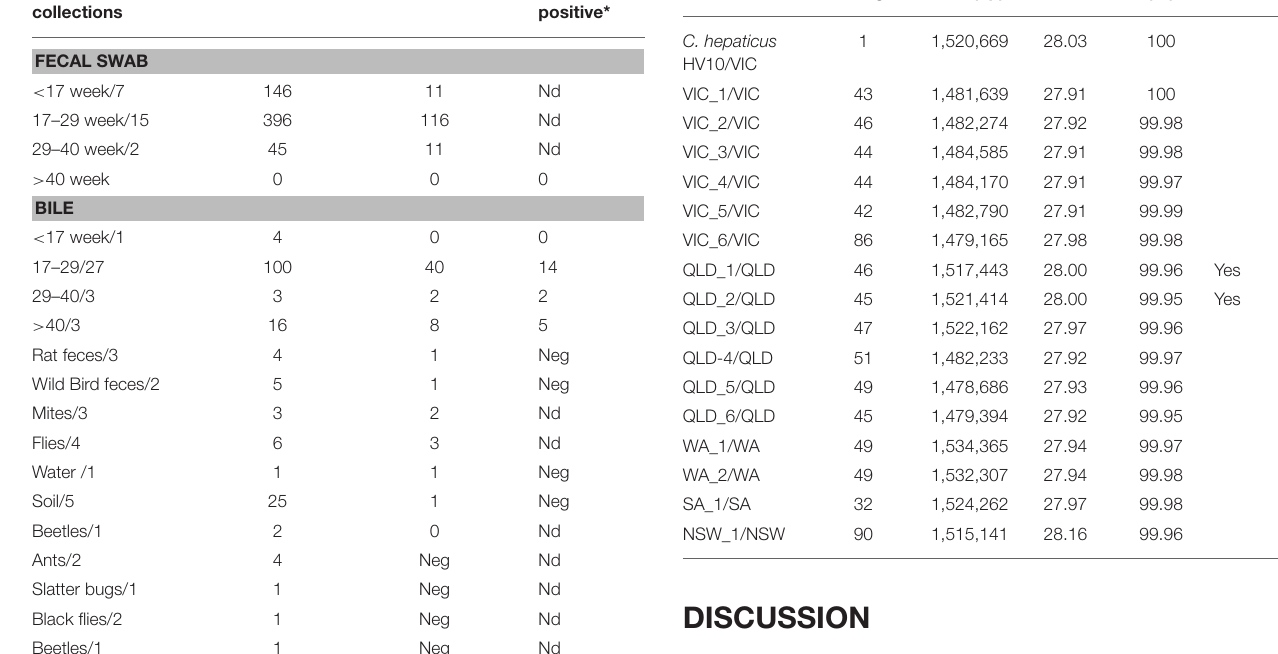
TABLE 2 | The presence of C. hepaticus in ad hoc samples collected around Australia. Sample types/number of